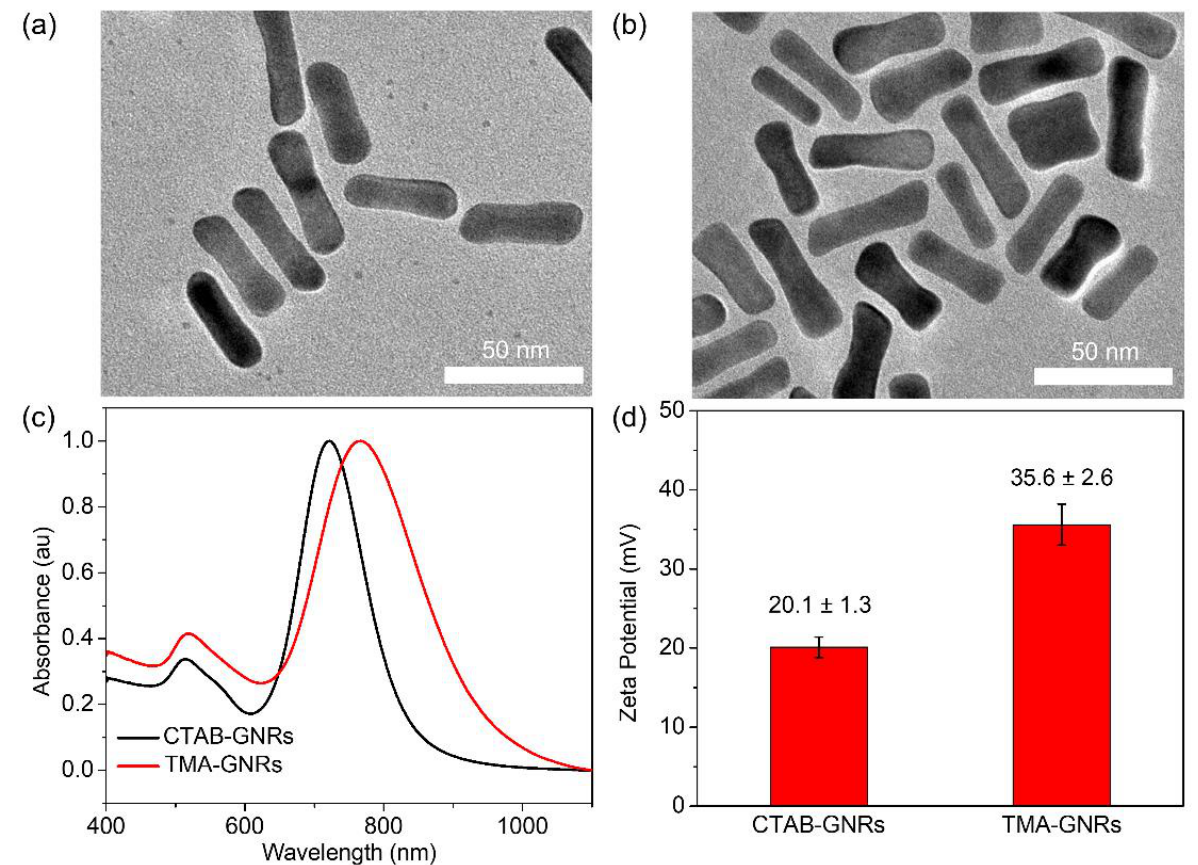
Figure 1. TEM images of ( a ) CTAB-GNRs and ( b ) TMA-GNRs; ( c ) UV-Vis spectra of CTAB-GNRs and TMA-GNRs; and ( d ) zeta potential of CTAB-GNRs and TMA-GNRs.